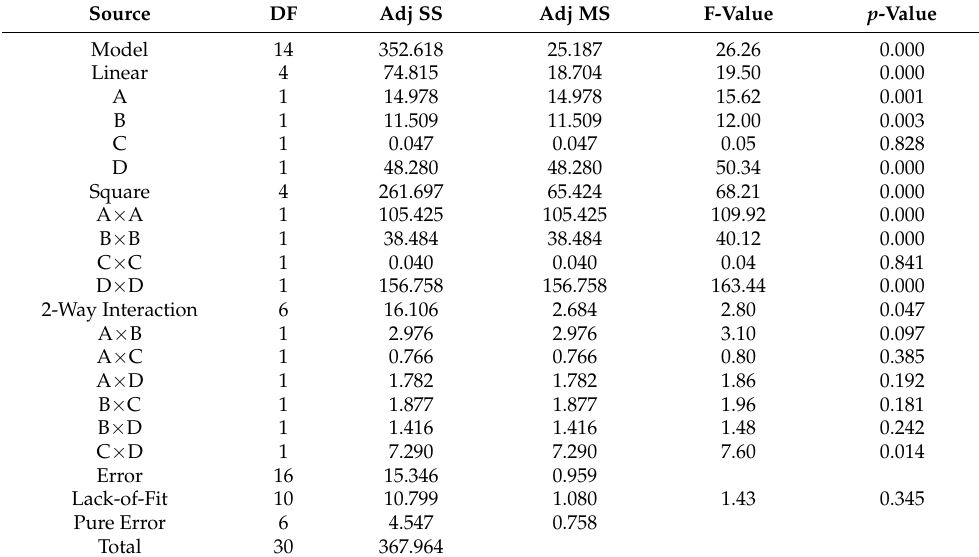
Table 3. Analysis of variance for ethanol production by S . cerevisiae .